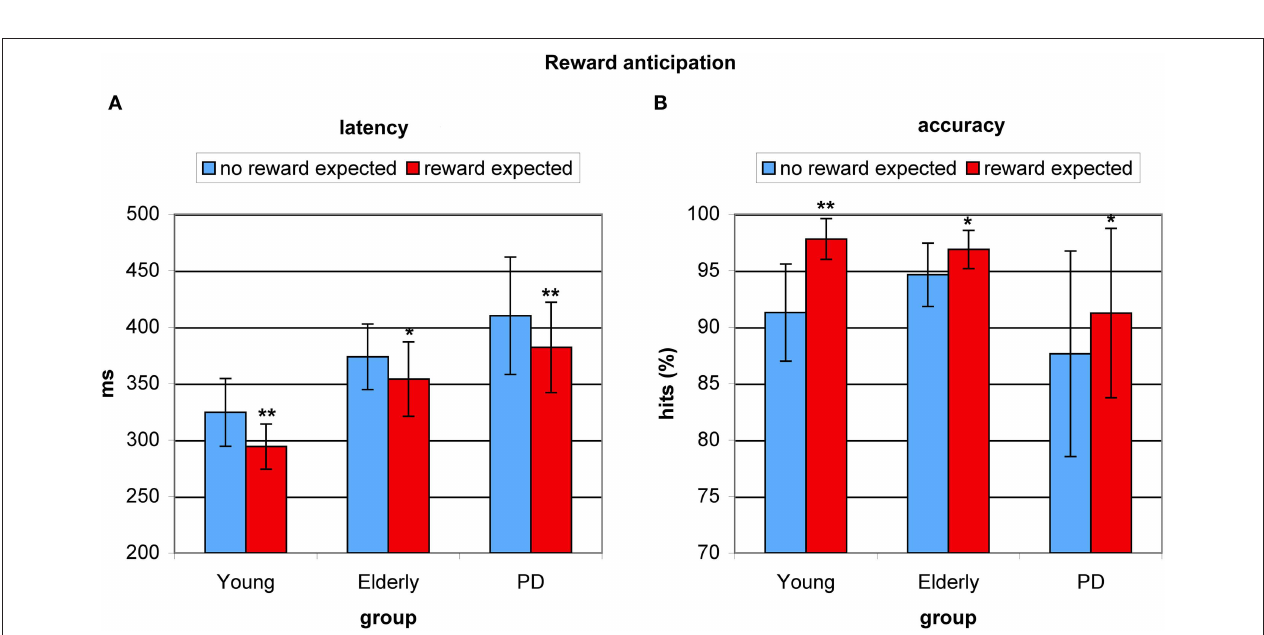
Figure 2 | Antisaccade latency and accuracy in young healthy participants, healthy elderly, and Parkinson’s patients (PD). (A) Increased average antisaccade onset latency in PD patients as compared to healthy elderly and in healthy elderly as compared to young participants. No significant differences in latency between healthy elderly and PD. (B) No significant differences between groups on average antisaccade accuracy. * P < 0.05; ** P <